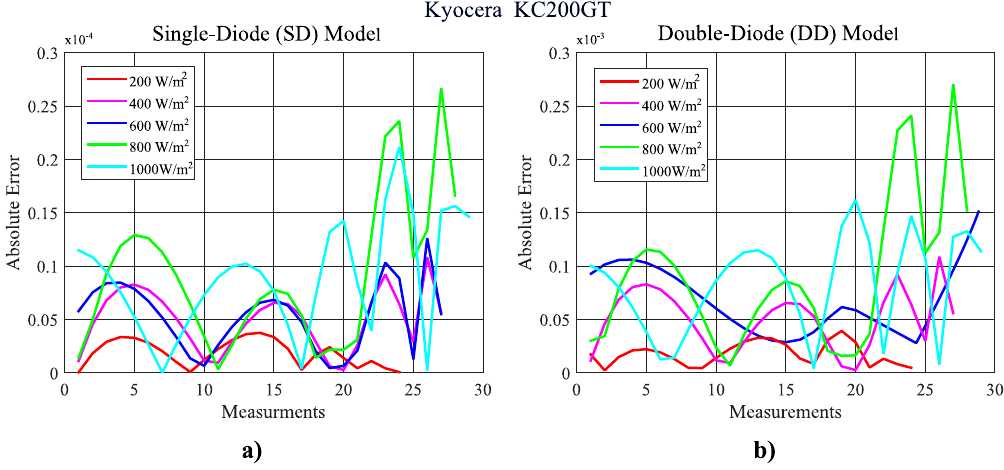
Figure 8. Absolute error curves between the measured and experimental I-V data at different irradiance levels (200, 400, 600, 800 and 1000 W/m 2 ) and fixed cell temperature ( T c = 33 ◦ C ) for an individual cell from a Kyocera KC200GT Solar Panel. ( a ) SD model and ( b ) DD model.